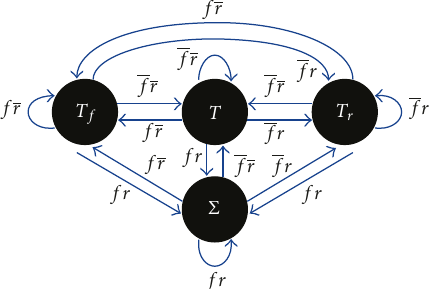
Figure 8: A finite state acceptor that describes the action selection scheme; T , T f , and T r represents unconstrained, forward-only and reverse-only taxis, respectively, while Σ is a searching behavior for the fall through case when neither T f nor T r can be used. The virtual senses f and r indicate that the forward and reverse obstacle sensors, respectively, are overstimulated, while f and r indicate the absence of overstimulation; the virtual senses are ANDed together to specify FSA